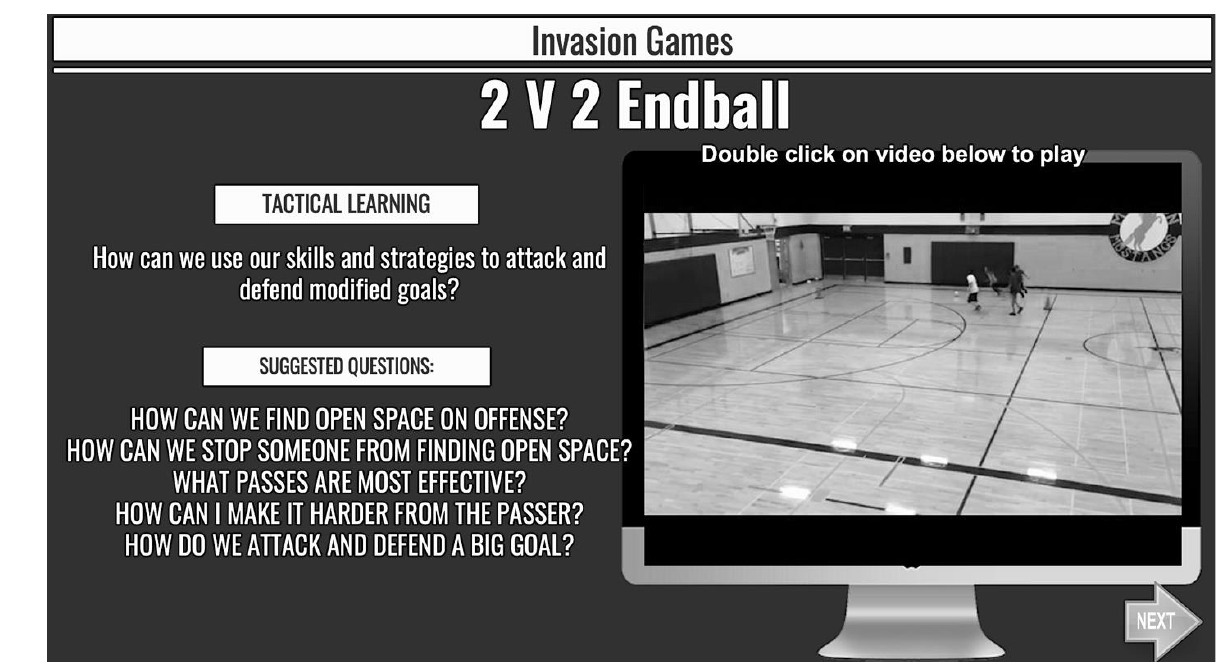
Figure 1. Instructional Slide Used as a Part of the FLA. Note. This figure contains the essential tactical learning question for the upcoming face-to-face lesson, as well as a video that describes and demonstrates the main applied activity students will participate in during class. The Suggested Questions represent areas of reflection and encourage students think about key tactical strategies that will be emphasized in upcoming lessons.